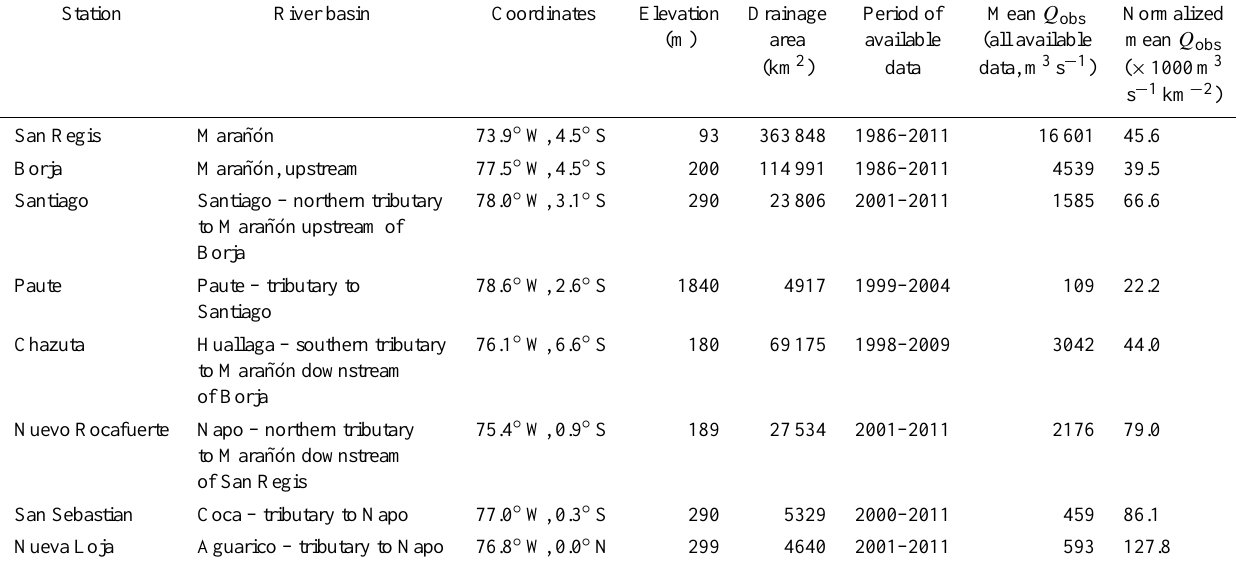
Table 2. Hydrological stations description. Station